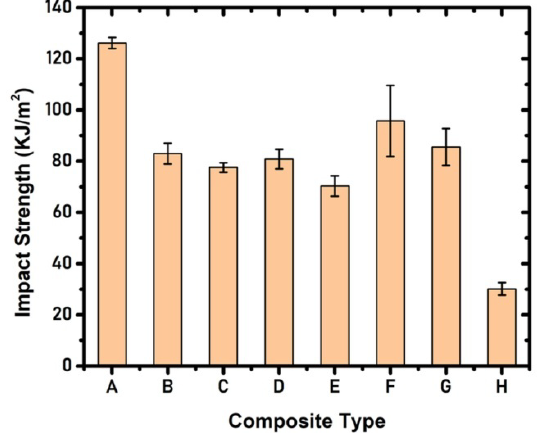
Figure 6. Izod impact strength of different composites.